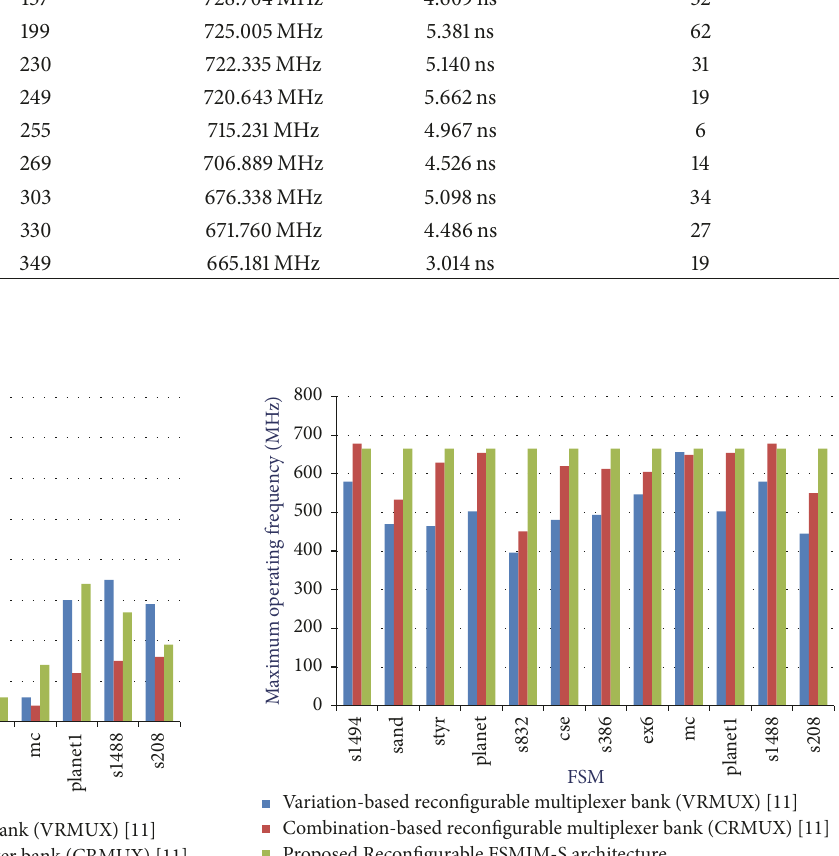
Figure 4: Comparison of operating speeds during FPGA imple-